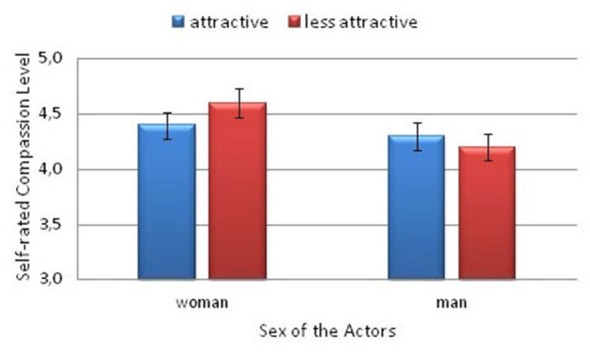
Self-rated compassion levels felt toward the models by the participants.